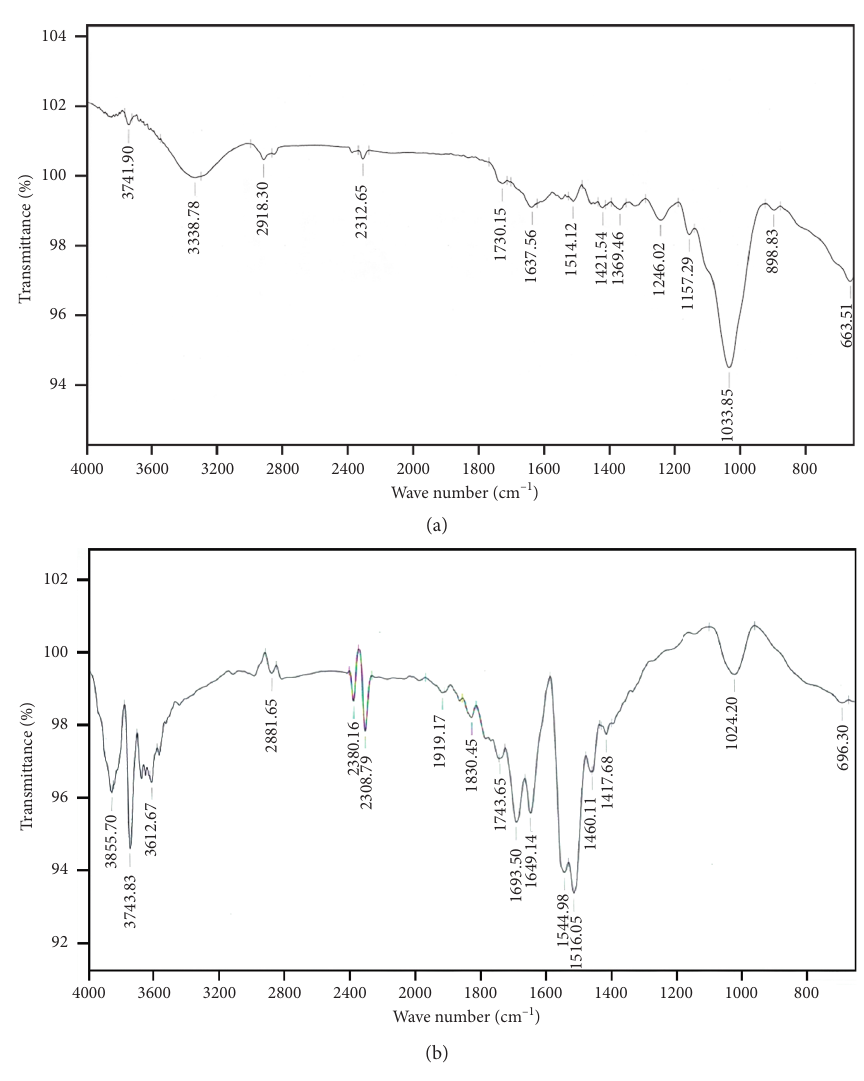
Figure 2: FT-IR spectra of (a) SB and (b)